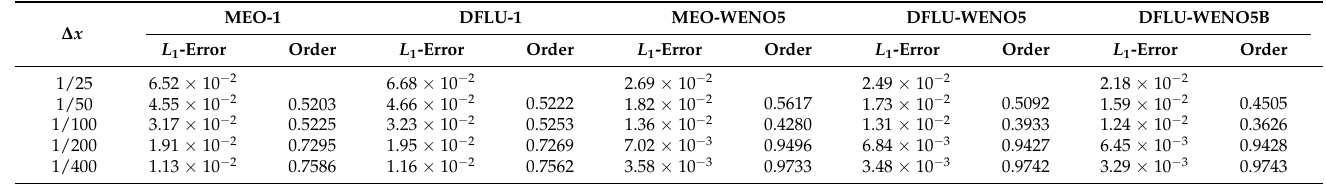
Table 2. L 1 -errors and orders of two types of MEO and DFLU schemes for Example 2.